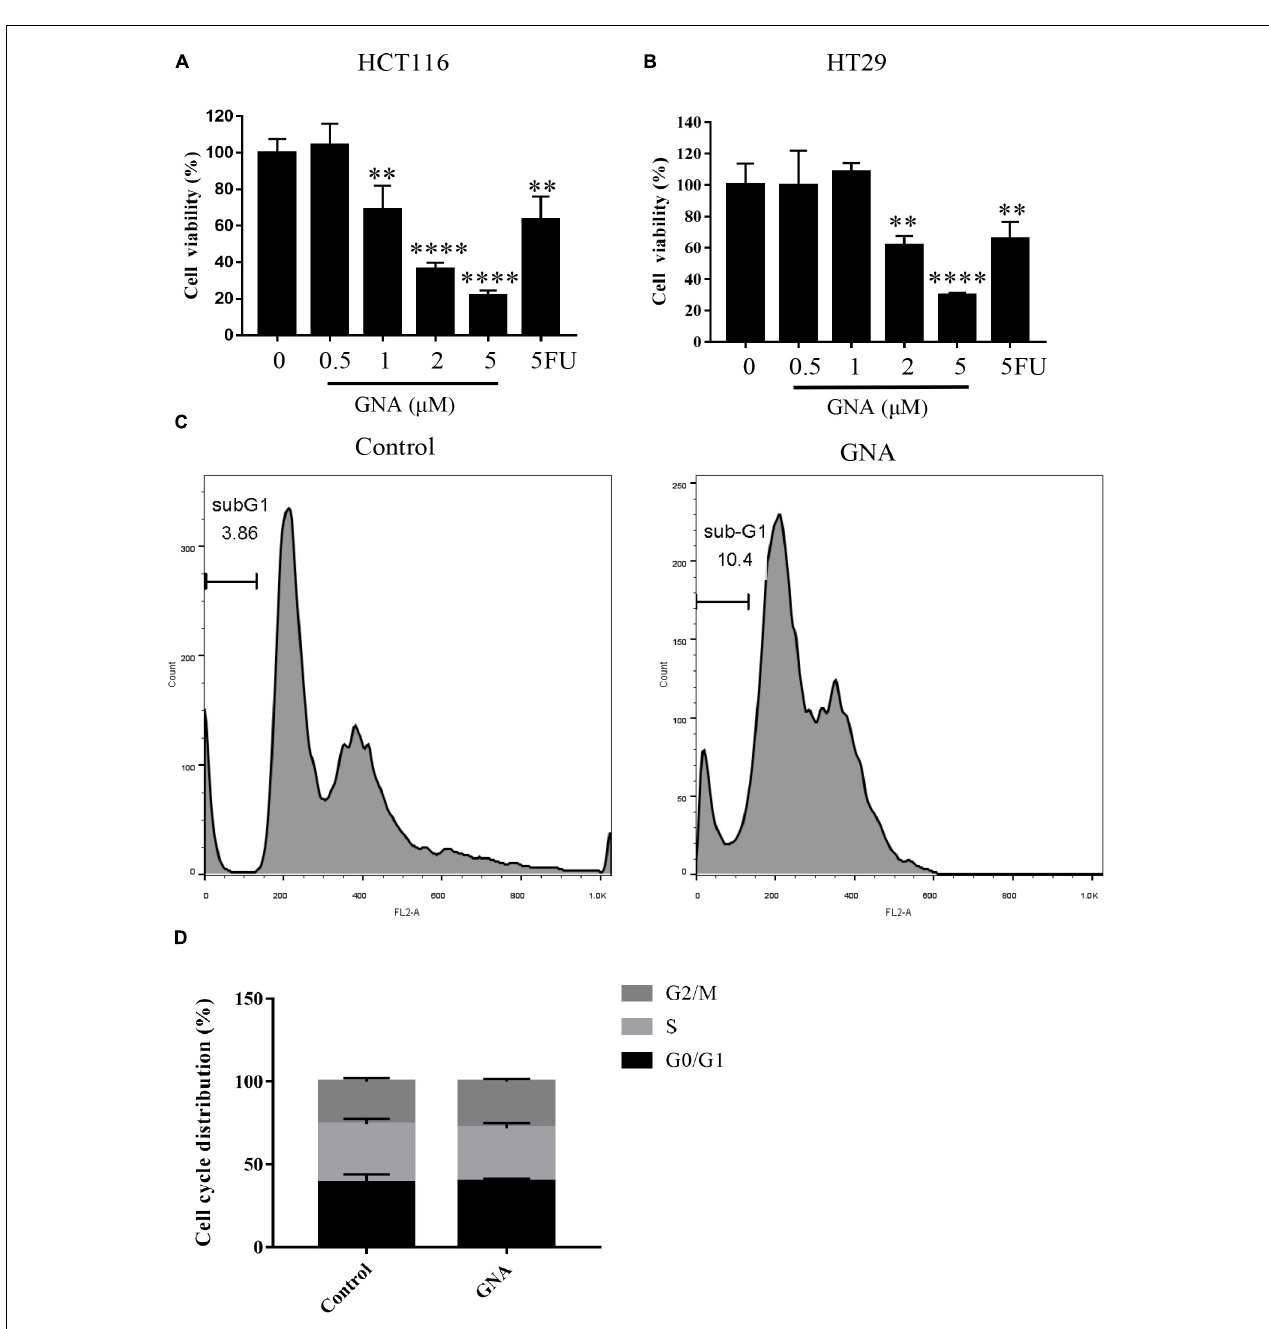
FIGURE 1 | GNA inhibited cell proliferation and induced apoptosis. HCT116 (A) and HT29 (B) cell viability was assessed using the MTT assay. Cells were treated with different concentrations of GNA (0–5 µ M) and 5FU (2 µ M) for 24 h. MTT solution was added to the well and incubated for 4 h at 37 ◦ C. The precipitate was dissolved in DMSO, and the absorbance was measured at 570 nm. (C,D) Cells were treated with GNA for 24 h, and then the distribution of the cell cycle was detected by flow cytometry after PI staining. The data are presented for at least three independent experiments. The data are presented as the mean ± SD. ** P < 0.01; **** P <